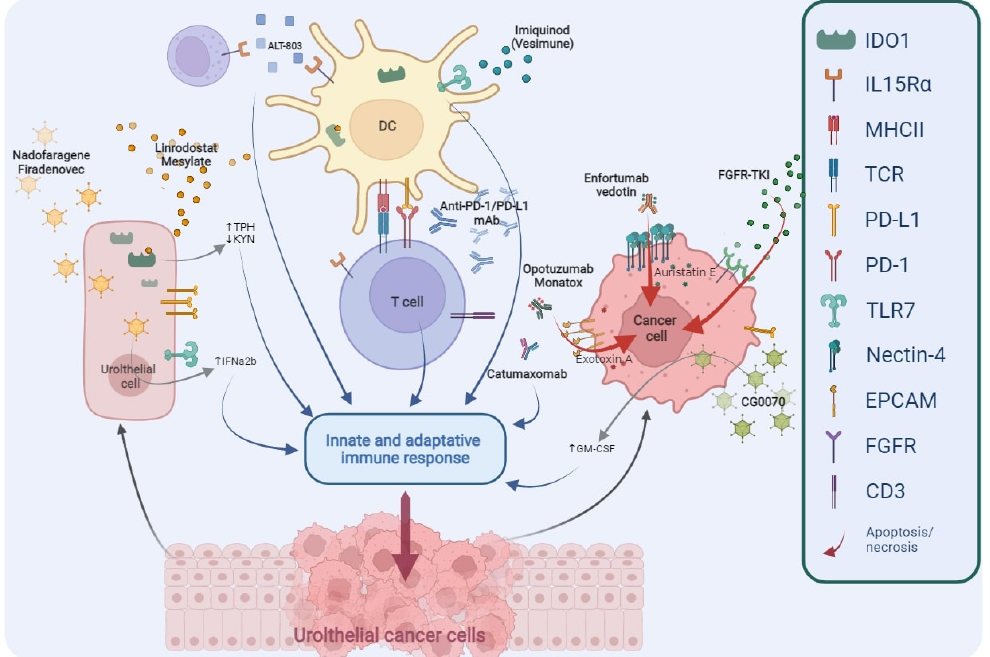
Figure 2. Main targets of novel drugs being investigated in BCG-unresponsive NMIBC. TPH, Tryptophan; KYN, Kynurenine; IFN α 2b, Interferon α 2b; DC, Dendritic Cell; PD1, Programmed cell Death protein 1; PD-L1, Programmed Death-Ligand 1; mAb, monoclonal Antibody; GM-CSF, Granulocyte-Macrophage Colony-Stimulating Factor; FGFR, Fibroblast Growth Factor Receptor; TKI, Tyrosine Kinase Inhibitors; IDO1, Indoleamine 2,3-Dioxygenase 1; IL-15R α , Interleukin-15 receptor α ; MHCII, Major Histocompatibility Complex Class II; TCR, T Cell Receptor; TLR7, Toll-like Receptor 7; EpCAM, Epithelial Cell Adhesion Molecule; CD3, Cluster of Differentiation 3.